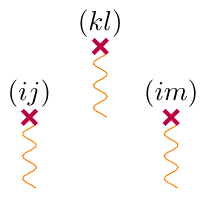
Figure 2 . Branching points and